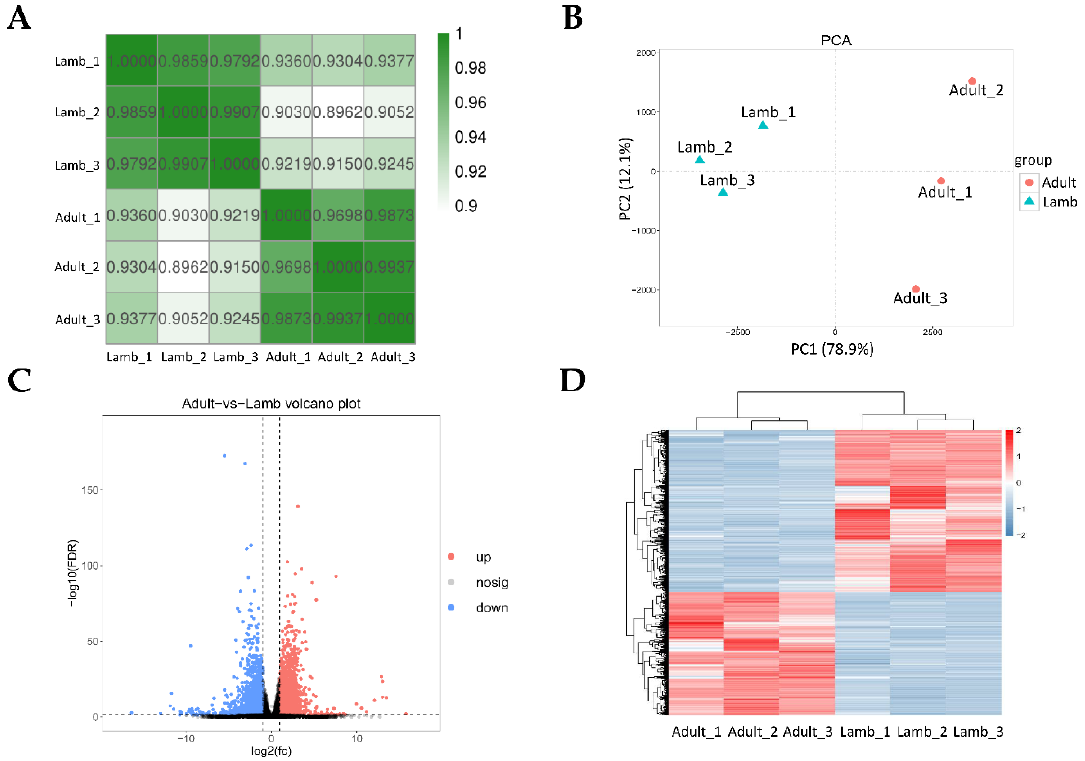
Figure 2. mRNA expression analysis for the ovaries of lambs and adult sheep under superovulation treatment. ( A ) Pearson correlation for mRNA expression values across samples. ( B ) PCA of mRNA expression values of the lamb and adult libraries. ( C ) Volcano plot of distribution for differentially expressed mRNAs. ( D ) Heat map analysis of differentially expressed mRNAs. Table 3. mRNAs associated with hormone receptors, steroid hormone secretion and oocyte quality were differentially expressed in the lamb and adult sheep libraries.